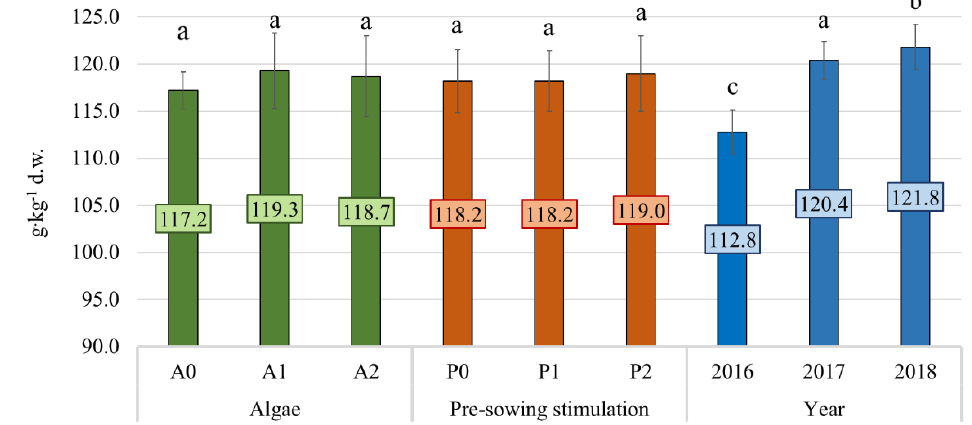
Figure 5. The mean raw fiber content of protein in oat grains in 2016–2018 depending on the experimental factors used. According to Tukey’s HSD test, the means marked with the same letter are not significantly different at α ≤ 0.05.